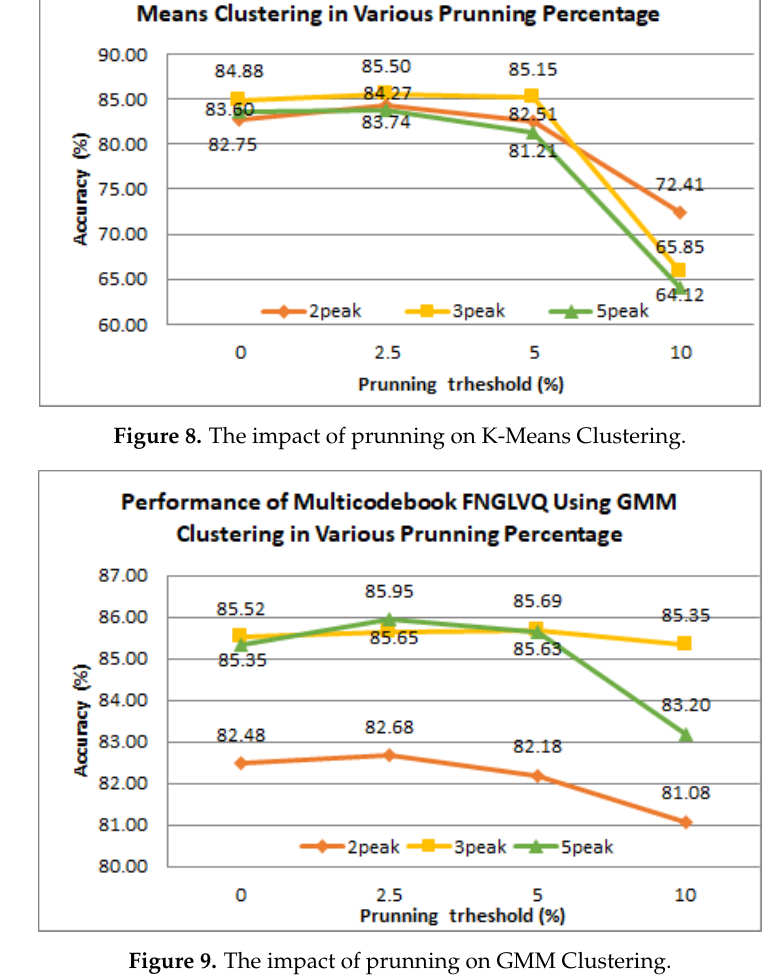
Figure 9. The impact of prunning on GMM Clustering.